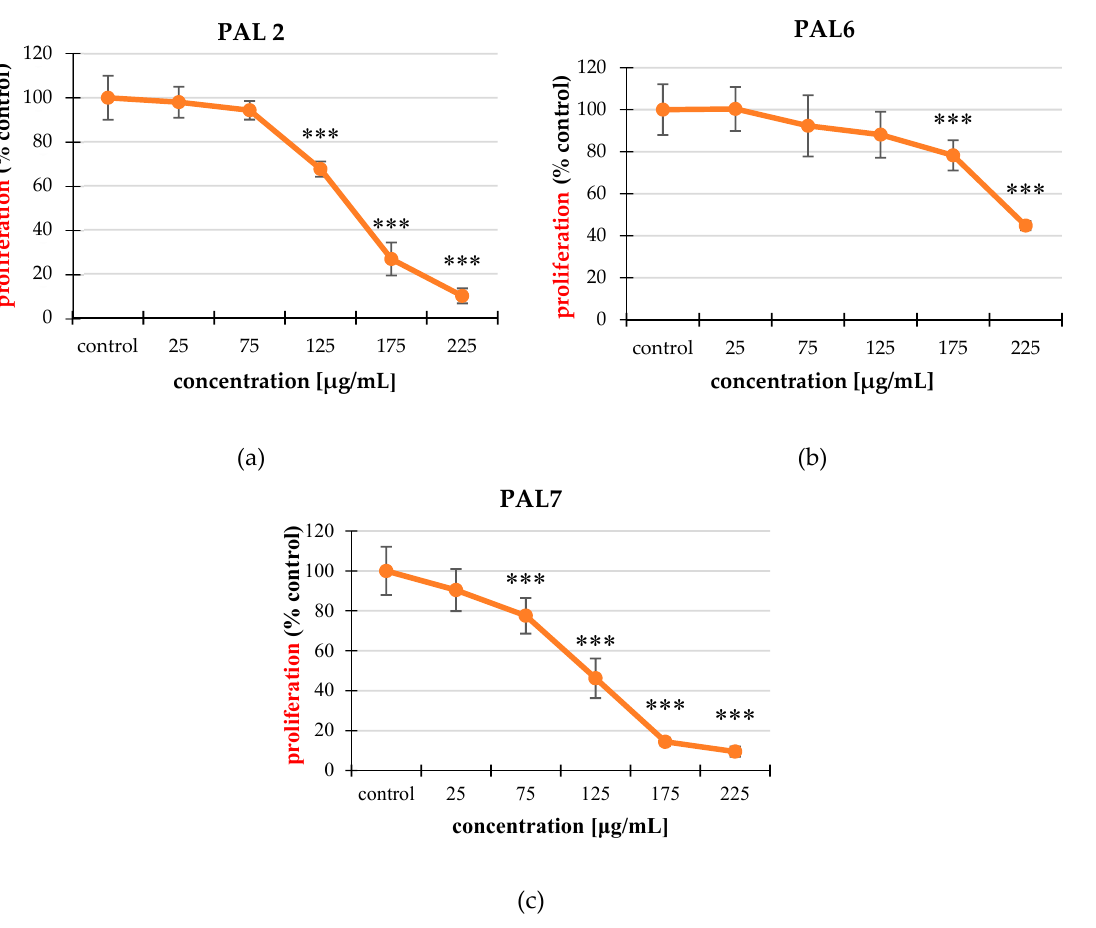
Figure 3. Inhibition of the line proliferation of the HT-29 line studied using an MTT assay. The most effective extracts were PAL2 ( a ), PAL6 ( b ), and PAL7 ( c ). The values are compared to the control regarded as 100%; * p < 0.01, ** p < 0.005, *** p < 0.001, one-way ANOVA, Dunnett’s test.